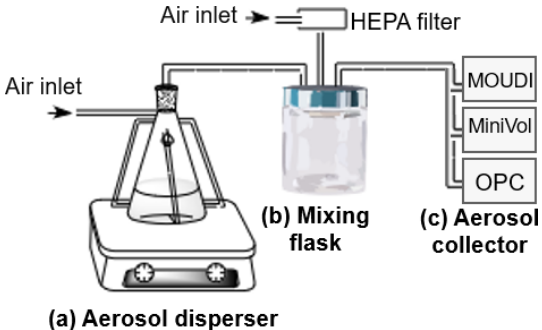
Figure 2. Dry aerosol generation system setup. (a) Aerosol dis- perser, (b) mixing volume, and (c) aerosol collector (MOUDI 100R, MiniVol TAS, or